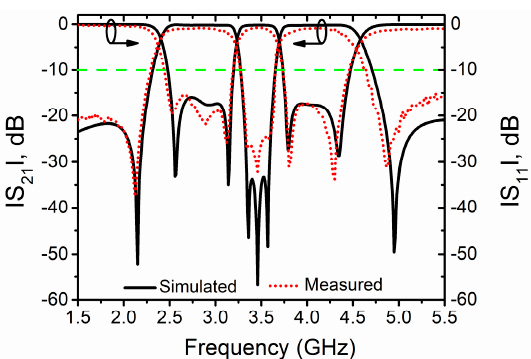
Figure 8. Filter responses of Case A ( C F = 100 pF, C S = 2.4 pF, C T = 100 pF).